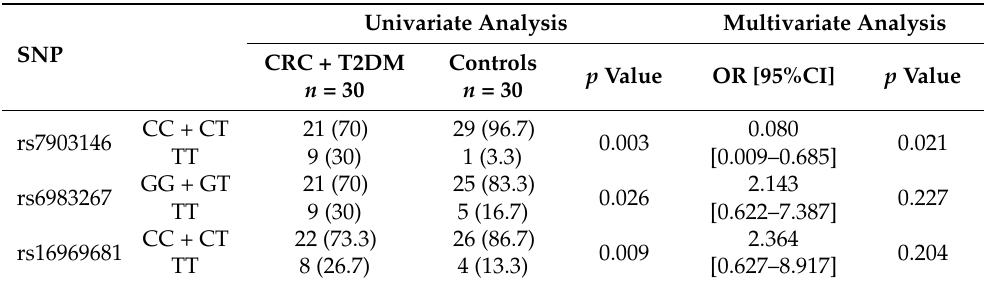
Table 4. Univariate and multivariate analyses for CRC and T2DM patients and control subjects.